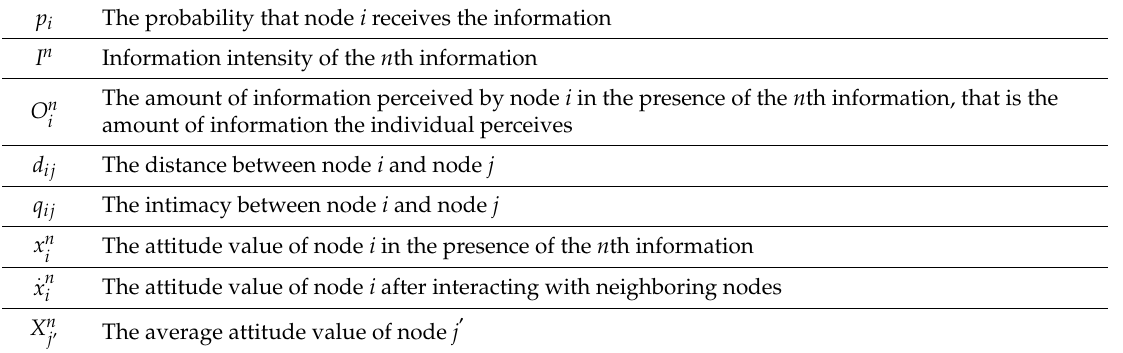
Table 2. Variables involved in the